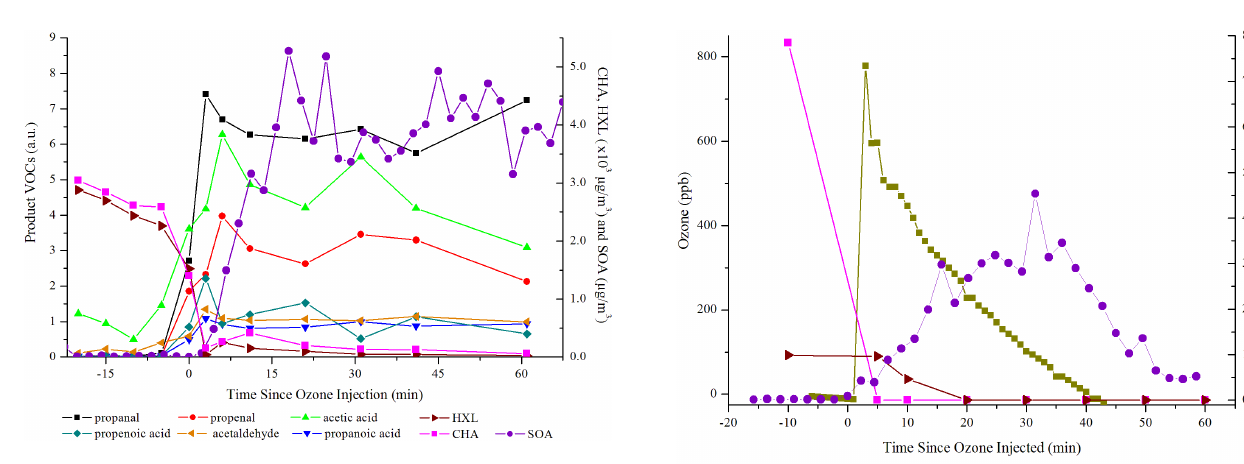
Fig. 4. Reaction profile of the ozonolysis of a 1 : 1 mix of CHA and HXL (initial concentration 2.8 ( ± 0.2) × 10 3 µgm − 3 each). 900ppb ozone was injected at time zero, after which SOA and volatile products (propanal, propenal, propenoic acid, acetic acid, propanoic acid, acetaldehyde) increased in signal. Lines between data points drawn to aid the eye.